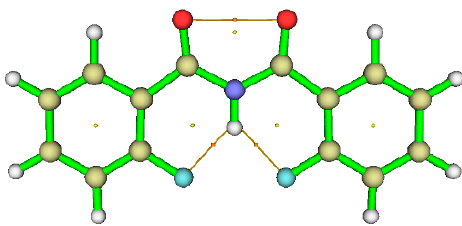
Figure 32. The visualization of BCPs and bond paths of HB for the molecule 26 plotted using the Multiwfn software. Dots represent the CPs and thin bar represents the HB interactions.